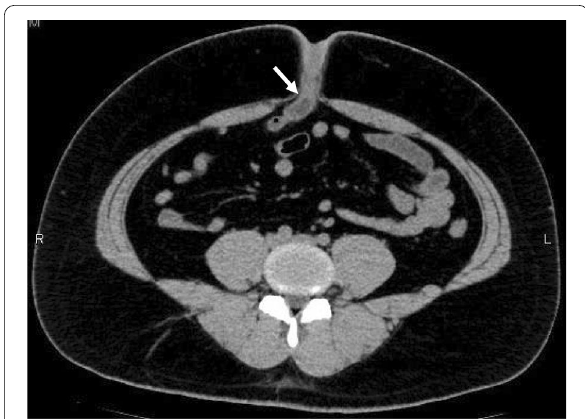
Fig. 1 CT image at first visit. A luminal structure with liquid retention is evident just below the umbilicus (arrow)